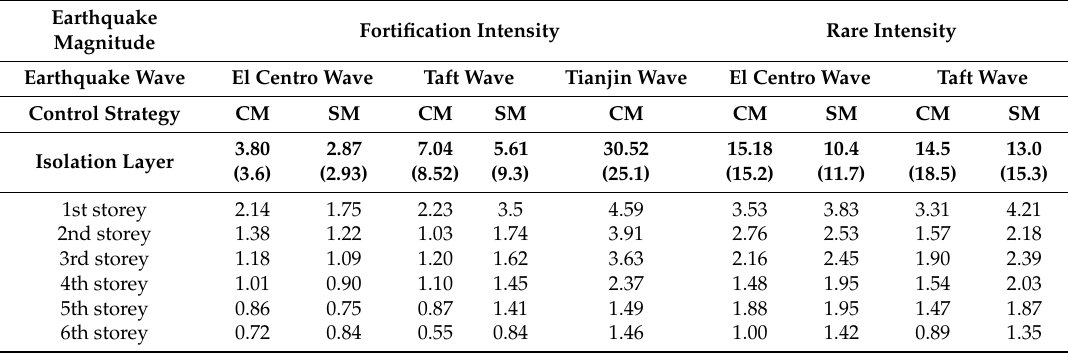
Table 4. Peak value of story drift under different intensities and seismic waves (mm).